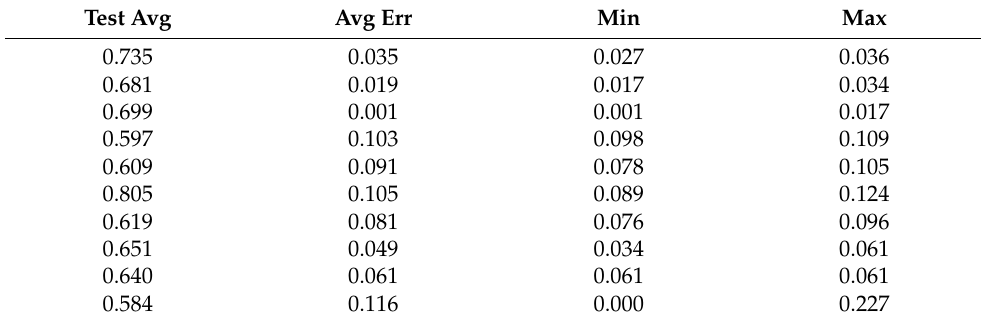
Table A131. Set 2, trials 31–40 data (all 0.5 PR values).